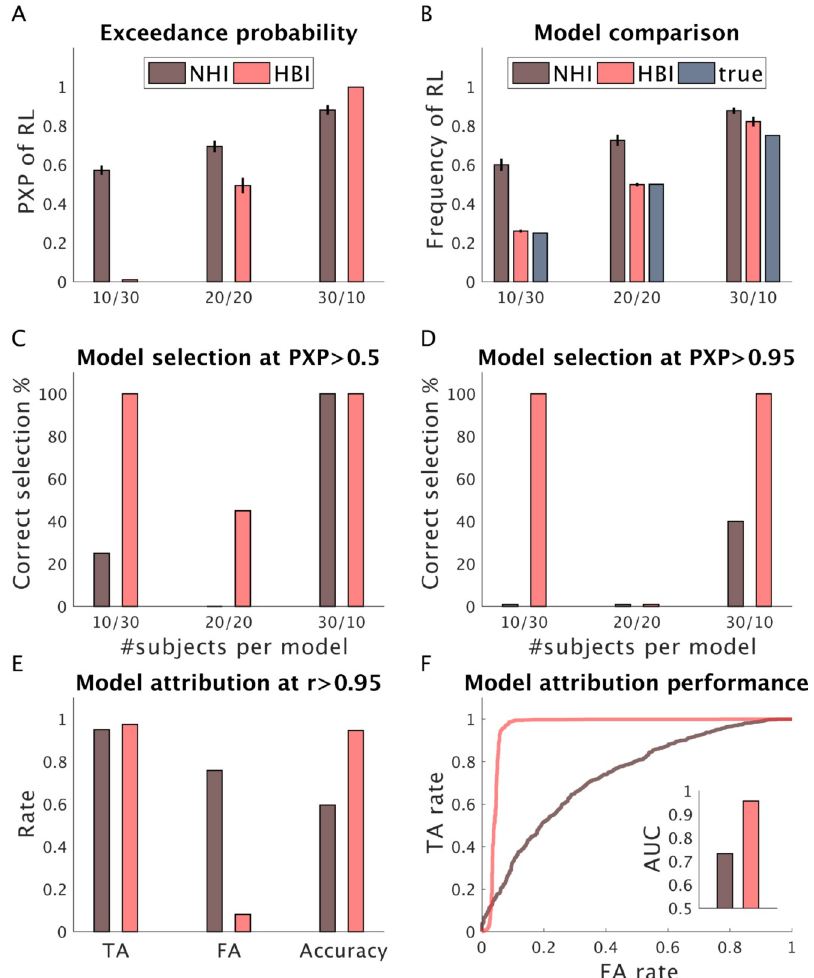
Fig 4. Comparison of HBI with NHI in model selection and model attribution. We compared the performance of HBI and NHI in three simulation analyses with different ratio of subjects expressing each model. The first simulation includes 10 subjects expressing RL and 30 subjects expressing dual- α RL model (10/30). The second one includes 20 subjects per model (20/20) and the third one includes 30 subjects expressing RL and 10 dual- α RL (30/10). A) Mean protected exceedance probabilities (PXP) estimated by the HBI and NHI; B) Mean model frequency of RL across all simulations (true frequencies are also plotted). C-D) Model selection performance at PXP > 0.5 (C) and PXP > 0.95 (D). For the 20/20 simulations, 50% of each model should be selected at the chance level, i.e. PXP > 0.5, and none of the models should be selected at PXP > 0.95. E) Model attribution performance, at the individual level, using responsibility ( r ) parameters at 0.95 thresholds across all three simulations. The HBI is more accurate than the NHI in model attribution and shows more true attributions (TA) and less false attributions (FA). E) ROC curves, across all three simulations, for HBI and NHI, which illustrate model attribution performance at various threshold settings. Inset: area under the curve (AUC) of the ROC, as a metric for model attribution performance. The HBI shows better performance than the NHI according to this metric. In A-B, error-bars are standard errors of the mean obtained across 20